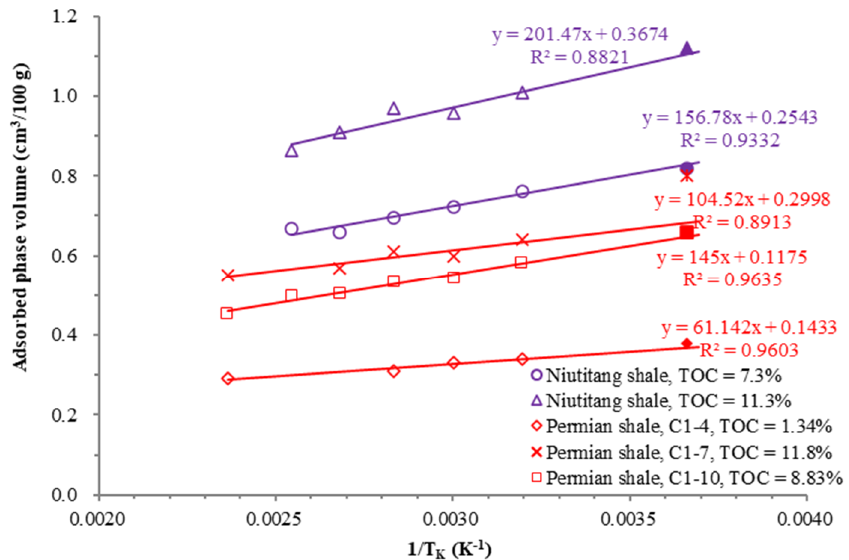
Figure 10. Plots showing the relationships between the reciprocal of the Kelvin temperature and the adsorbed phase volume of Permian and organic-rich Niutitang shales [14]. (The hollow icons represent the adsorbed phase volume, and the solid icons represent the CO 2 micropore volume obtained at 273.15 K).